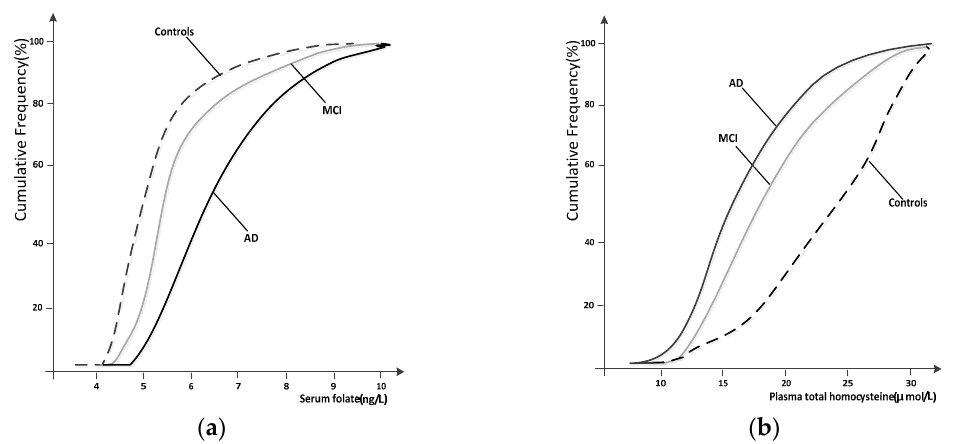
Figure 2. Cumulative frequency distributions of serum folate ( a ) and plasma homocysteine (Hcy) ( b ) levels in the healthy controls, MCI and AD subjects.